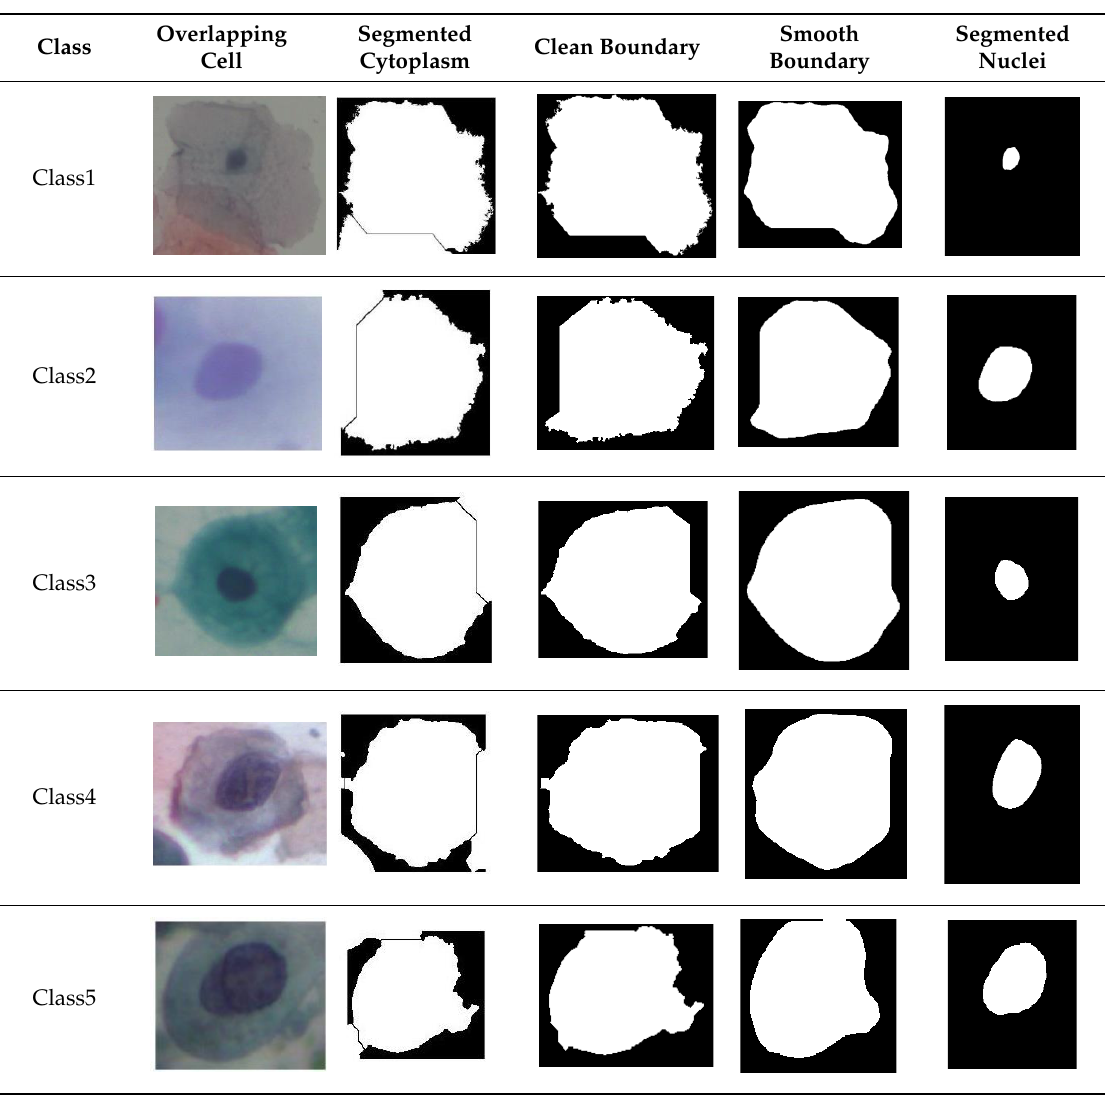
Table 9. Nuclei and Cytoplasm Segmentation for overlapping cells.